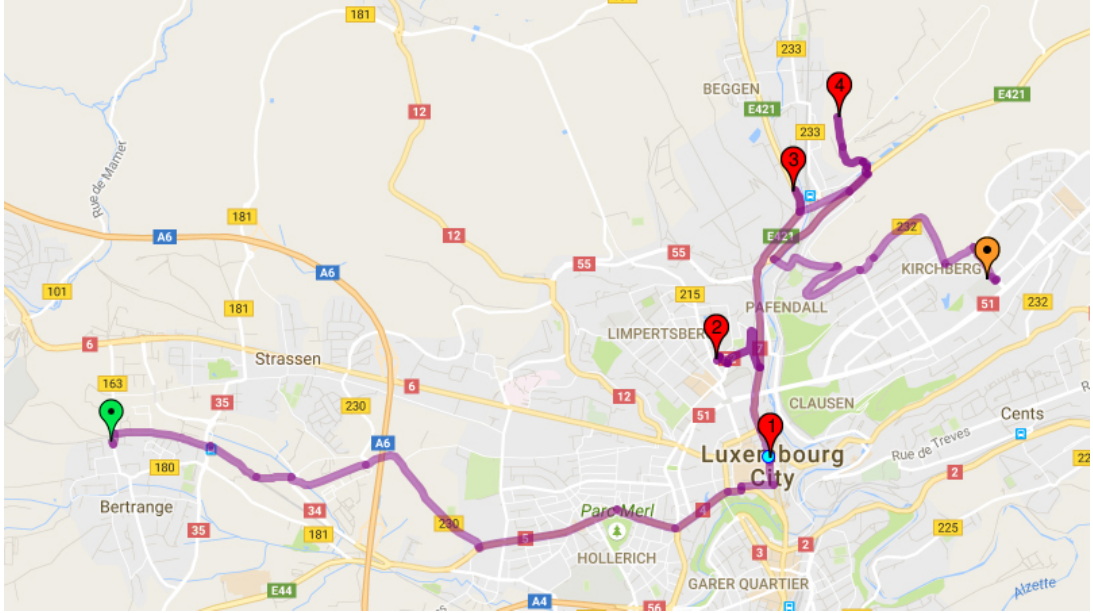
Figure 7. Shortest path between all of the residences and the